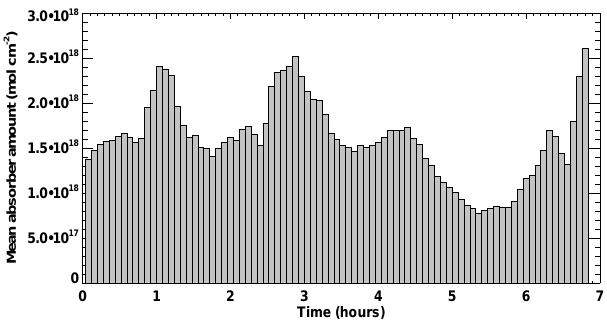
Figure 16. Variation of the mean SCD (moleculescm − 2 ) as a func- FIGURE16. VariationofthemeanSCD(moleculescm (cid:0) 2 )asafunctionoftimefortheEtnaplumeover aperiodof7hours,startingfrommidnightuntil07:00LTthefollowingday. tion of time for the Etna plume over a period of 7h, starting from midnight until 07:00LT the following